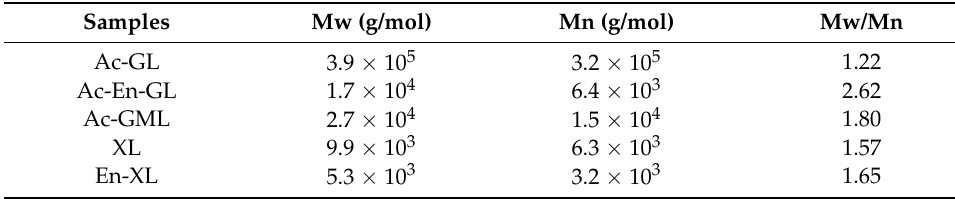
Figure 3. X-ray diffraction spectra of CW-DHP, BM CW-DHP, GL enriched with [ 13 C- 2 H] and Cellulose I and II. Table 4. Determination of molecular weights of different LCC